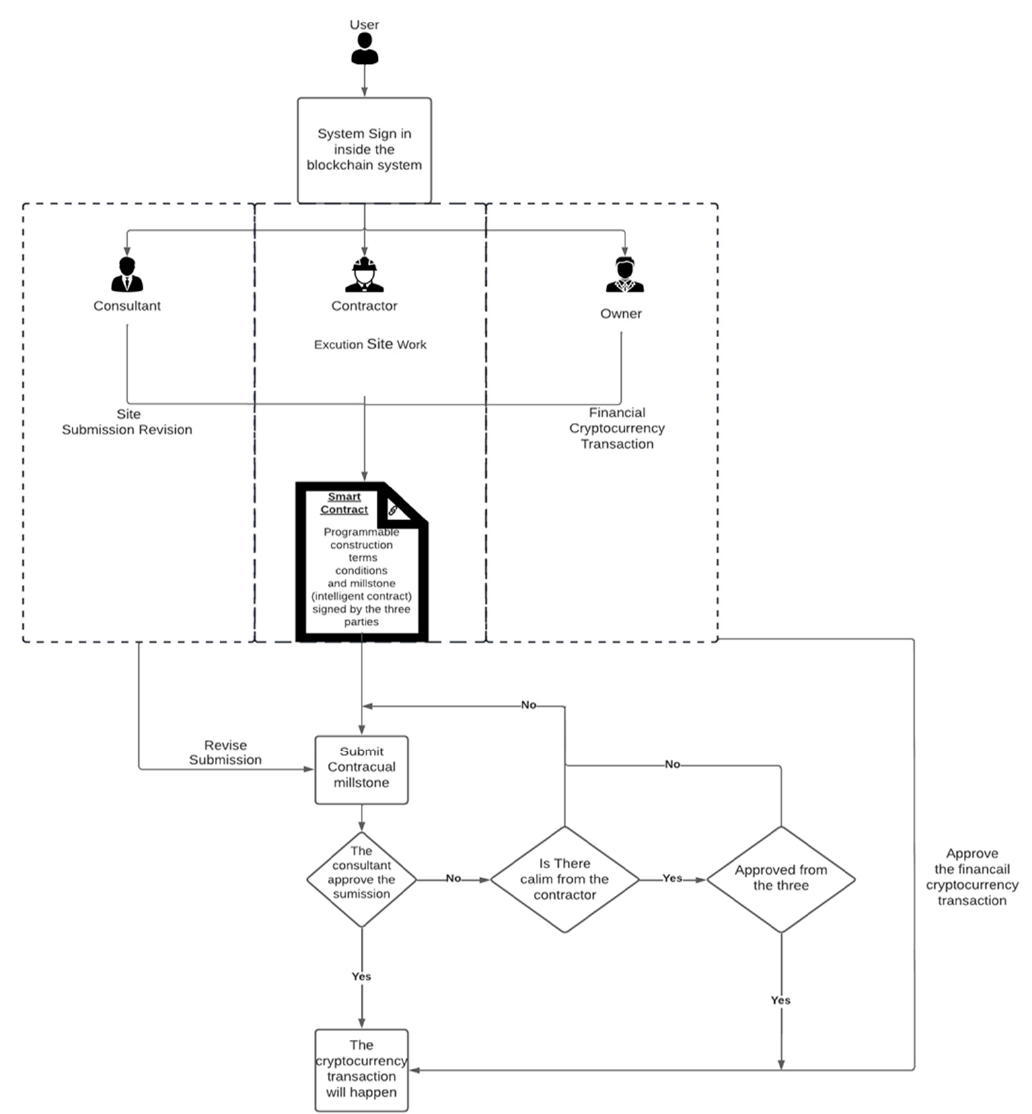
Figure 6. Data relations among parties in the developed prototype.